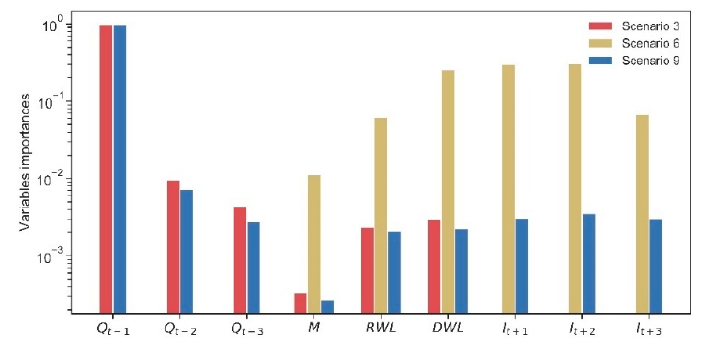
Figure 3. Variable importance scores in different scenarios.